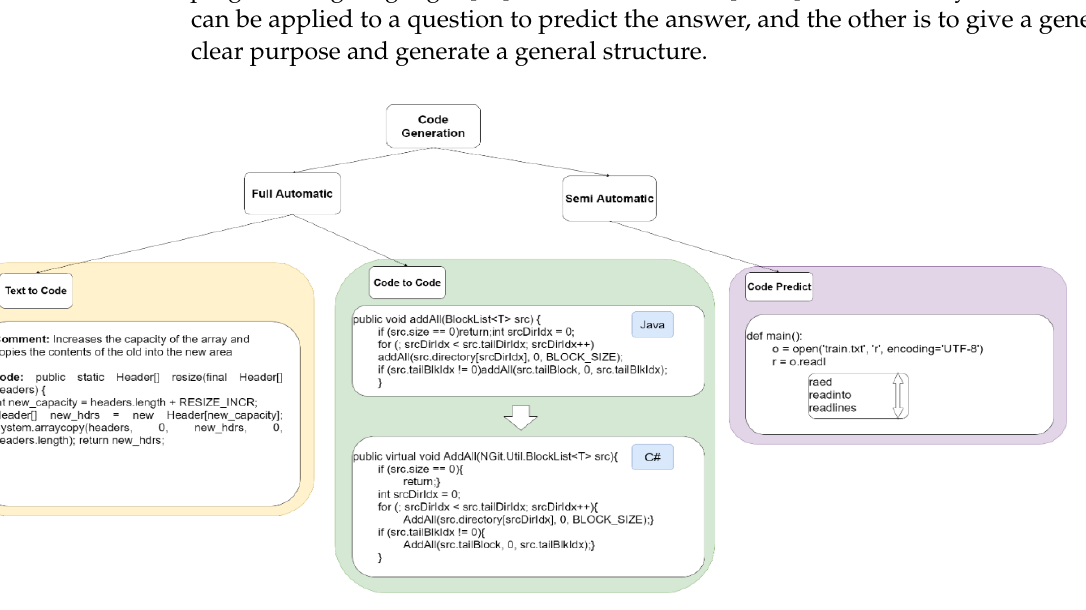
Figure 1. Field of code generation.